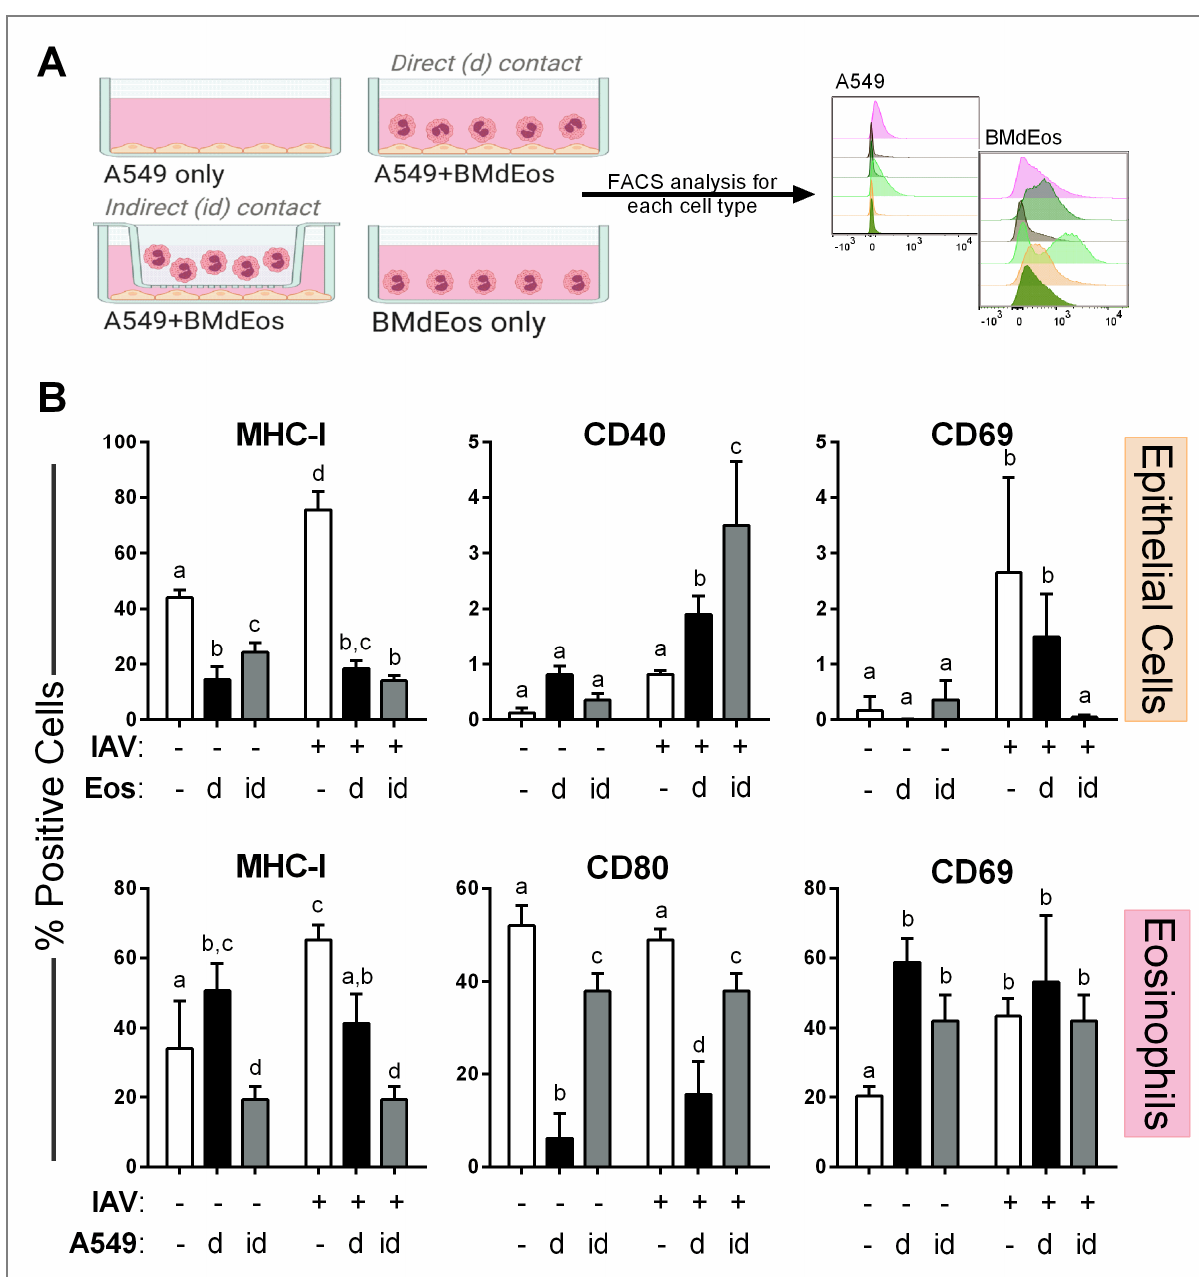
Figure 6. Cross activation of epithelial and eosinophils occurs in response to influenza A virus. ( A ) A549 epithelial cells and bone marrow-derived eosinophils were cultured directly/indirectly after infecting epithelial cells with pH1N1 influenza A virus and each cell type was analyzed by flow cytometry. Illustration with BioRender. ( B ) Surface expression of markers on epithelial cells ( C ) and eosinophils. Data represented as the mean and standard deviation of n = 5–6 samples analyzed by two-way ANOVA with Tukey’s multiple comparisons test of one of three independent studies. Differences are significant ( p < 0.05) when letters above bars are dissimilar. BMdEos—bone marrow-derived eosinophils; d—direct contact; id—indirect